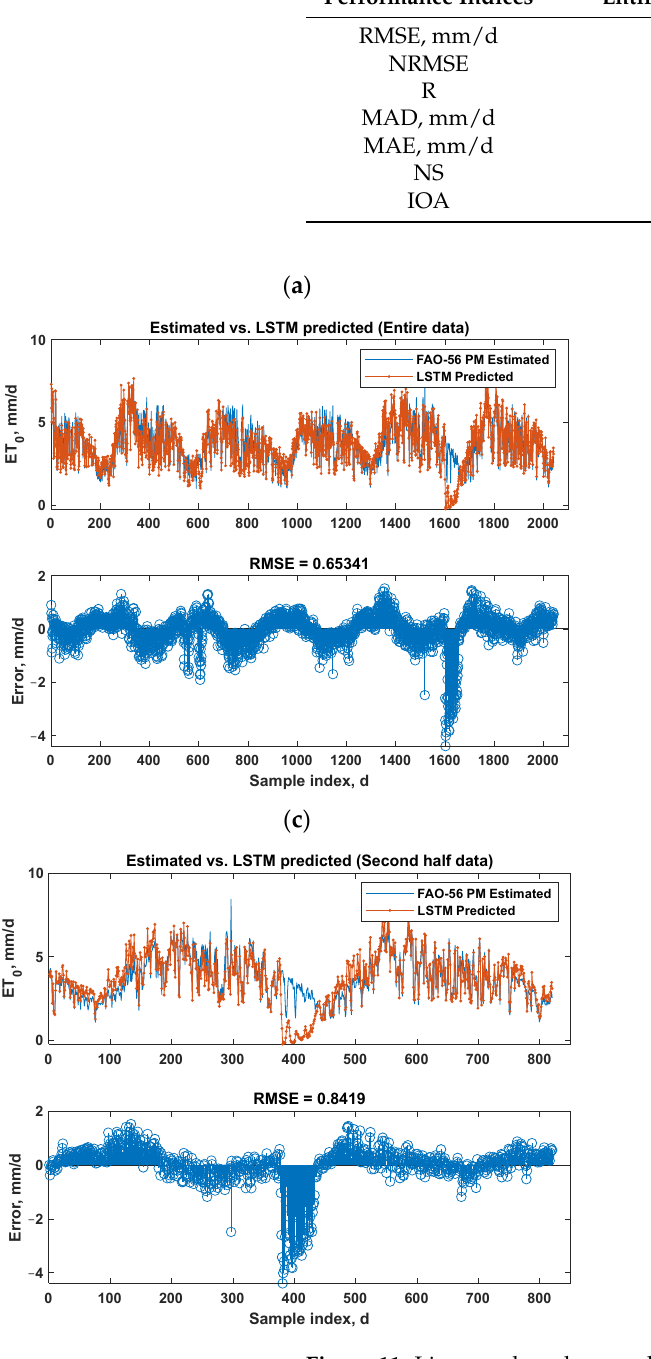
Figure 11. Line graph and error plots of FAO-56 PM-computed and LSTM-predicted daily ET 0 at Ishurdi station: ( a ) entire dataset, ( b ) first half of the dataset, and ( c ) second half of the dataset.